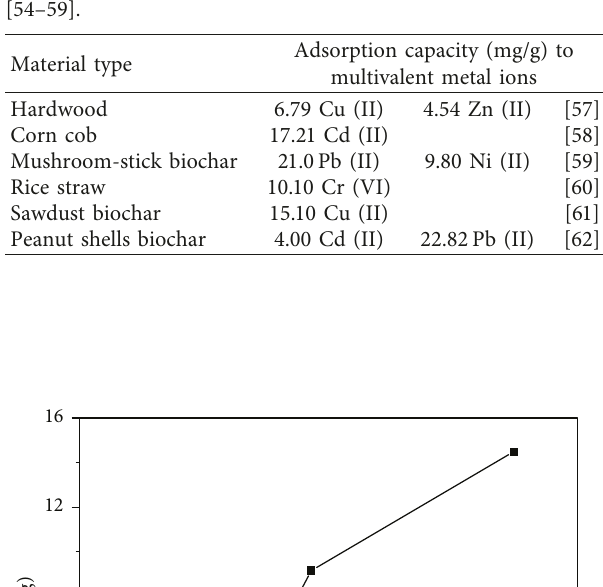
Figure 7: Nitrogen adsorption-desorption isotherms of PRC and DPRC (a); BJH pore size distribution of PRC and DPRC (b). Table 3: Maximum adsorption capacities of different types of Table 2: Void correlation coefficient of PRC and DPRC.